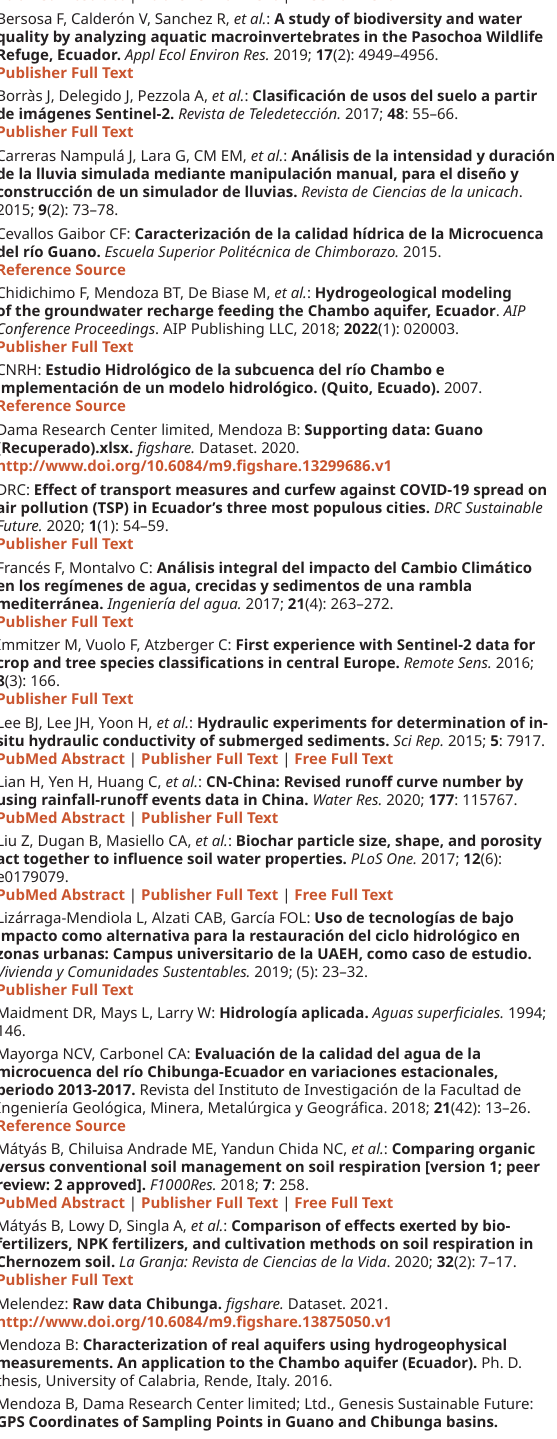
figshare. Dataset. 2021. http://www.doi.org/10.6084/m9.figshare.13874696.v